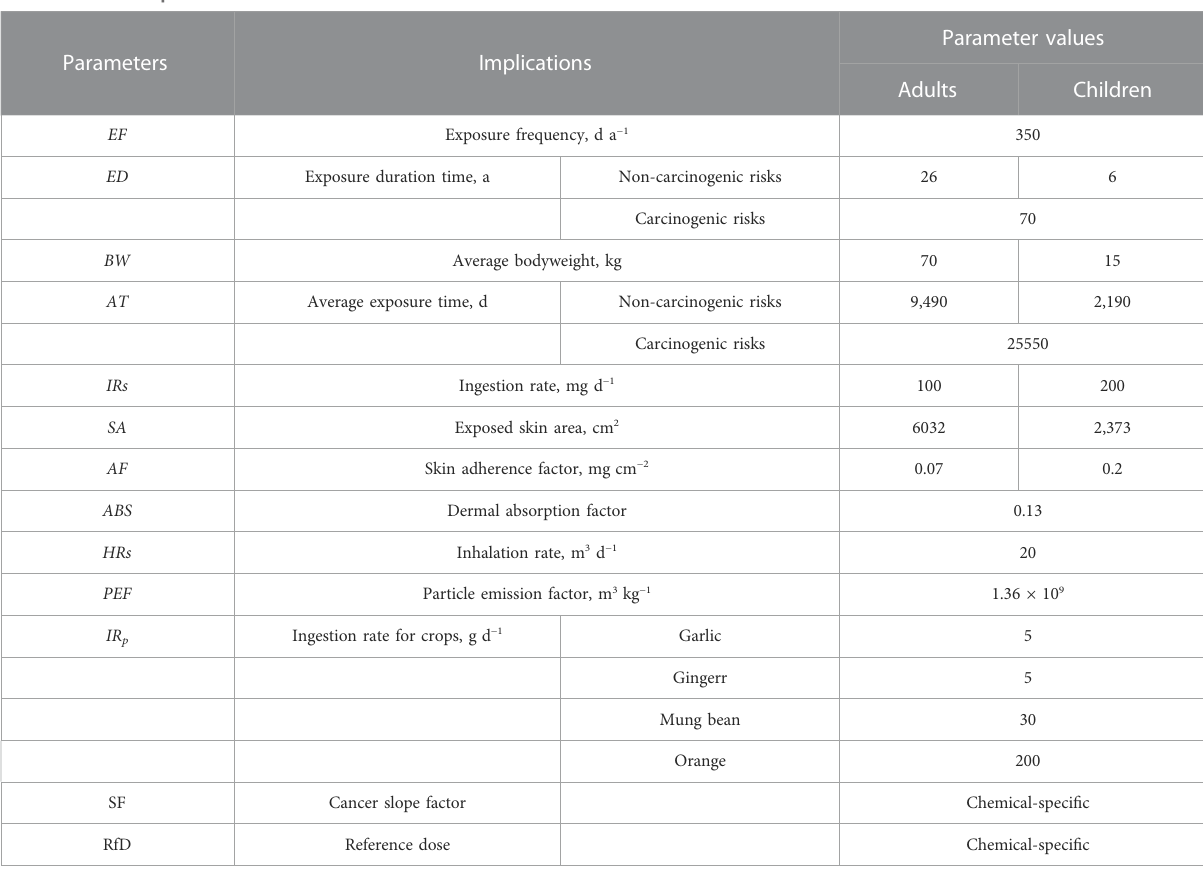
TABLE 2 Associated parameters used for the risk